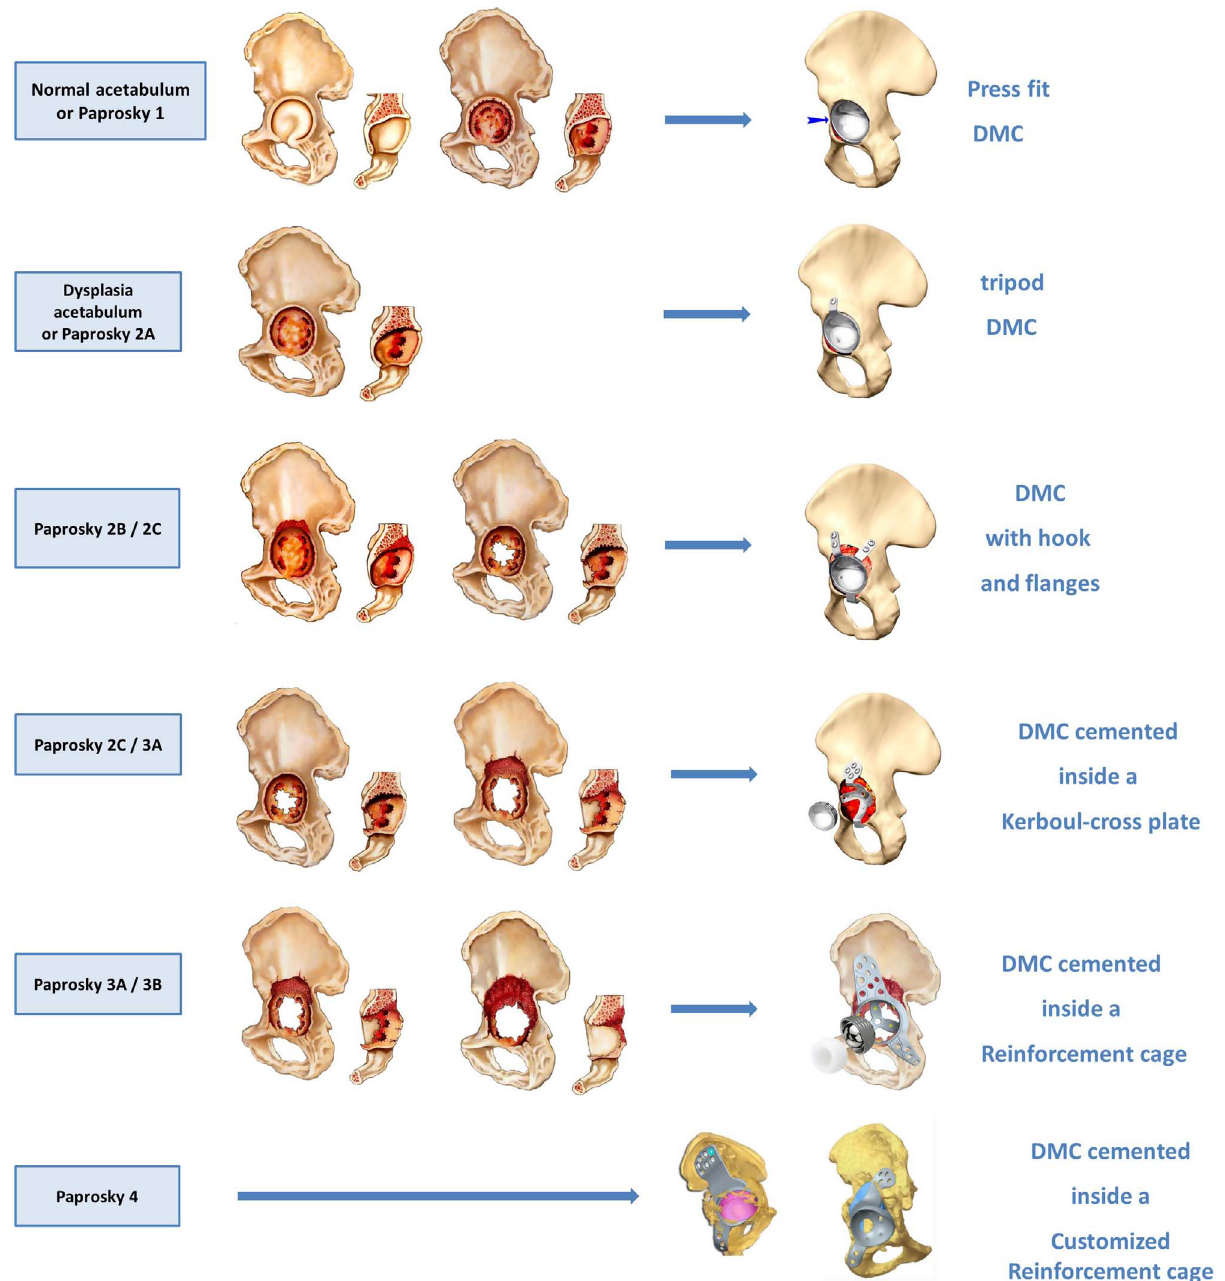
Figure 1. DMC choice regarding Paprosky classi fi cation (reprinted with SERF (cid:3)